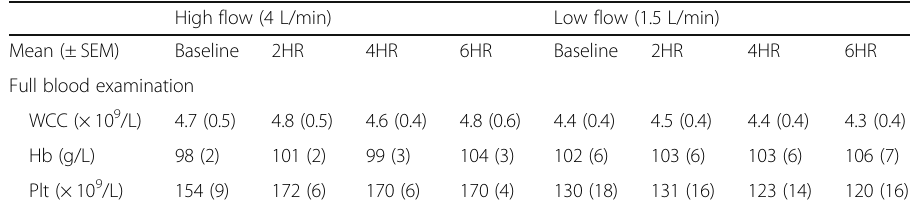
Table 1 Haemostatic parameters by experimental group at selected time points High flow (4 L/min) Low flow (1.5 L/min) Mean (± SEM)